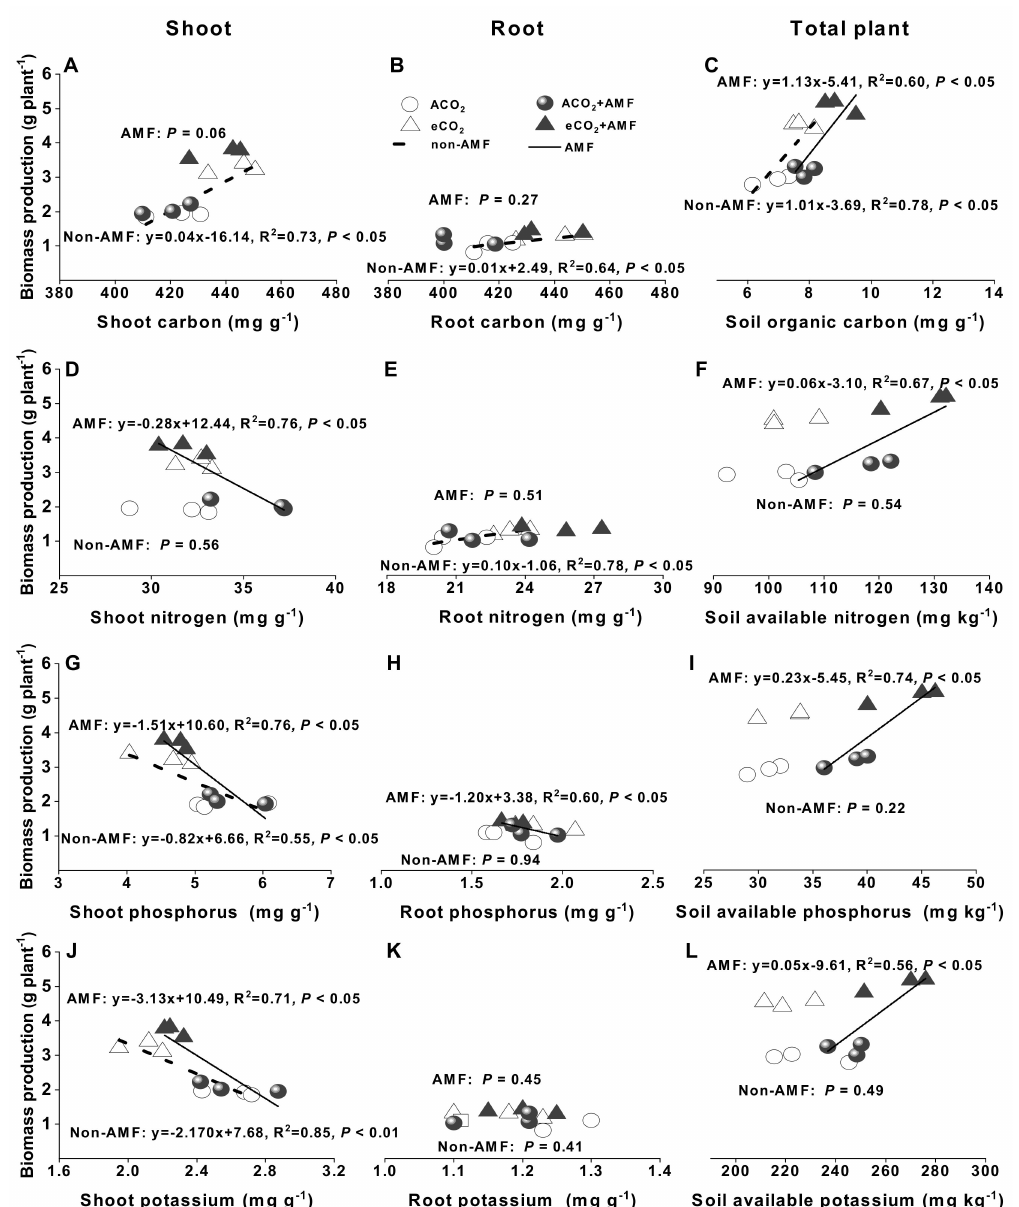
Figure 5. Relationships between carbon ( A – C ), nitrogen ( D – F ), phosphorus ( G – I ), and potassium ( J – L ) concentration in shoots, roots, and soils and plant biomass production of Funneliformis mosseae inoculated faba beans grown for 12 weeks at ambient CO 2 (ACO 2 ) and elevated CO 2 (eCO 2 ). Open circles and triangles represent data under ACO 2 and eCO 2 in non-AMF plants, and closed circles and triangles represent data under ACO 2 and eCO 2 in AMF plants, respectively. Regressions are shown for non-AMF (dotted lines) and for AMF (solid lines) treatments, n = 6. Root biomass production was significantly positively correlated to root C or N con- centration in non-AMF plants (R 2 = 0.64–0.78, P < 0.05, Figure 5B,E), but not in AMF plants ( P = 0.27–0.51, Figure 5B,E), while significantly negatively correlated to root P concentra- tion in AMF plants (R 2 = 0.60, P < 0.05, Figure 5H), but not in non-AMF plants ( P = 0.94, Figure 5H). No relationships between root biomass production and root K concentration were observed in both AMF and non-AMF plants ( P = 0.41–0.45, Figure